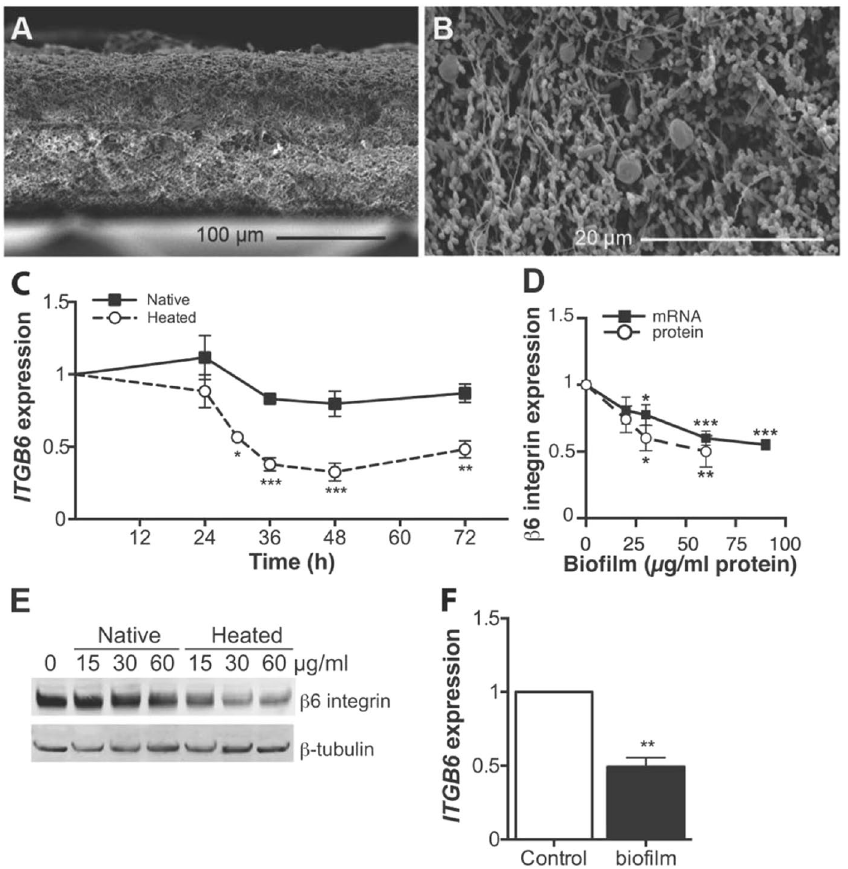
Figure 2. Structure of the bacterial biofilm and its effect on GEC β 6 integrin expression. ( A and B ) Cross section SEM micrographs of multi-species oral bacterial biofilms cultured for three weeks showing the structural features of the biofilm. ( A ) scale bar = 100 μ m; ( B ) scale bar = 20 μ m. ( C ) The time course of β 6 integrin mRNA expression in GECs treated with native or heated biofilm extract (#4 biofilm; 60 µ g protein/ ml) relative to untreated cells. Mean ± SEM of three experiments is presented. ( D ) Integrin β 6 mRNA and protein expression in GECs treated with different amount of heated biofilm extract (#4 biofilm) for 32 and 48 h, respectively. The protein levels were quantified relative to β -tubulin. Mean ± SEM of five experiments is presented. ( E ) Representative Western blot image of the total β 6 integrin protein levels in GECs treated with various doses of native or heated #4 biofilm extract for 48 h relative to β -tubulin. ( F ) Primary human GECs were exposed to heated oral biofilm extract (60 µ g protein/ml) for 30 h and the relative gene ITGB6 expression analyzed by RT-qPCR. Mean ± SEM of three experiments is presented. * p < 0.05; ** p < 0.01; *** p <